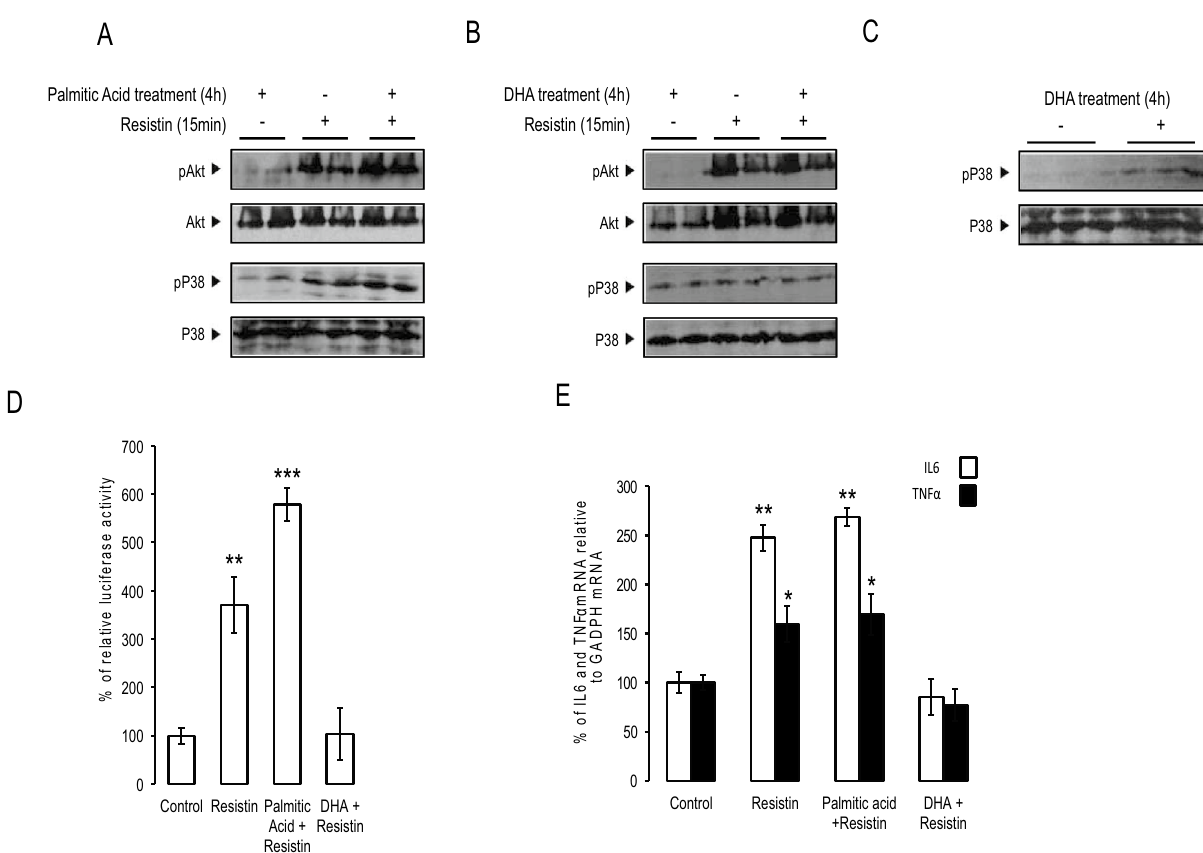
Figure 4. Palmitic acid promoted resistin action. Human SH-Y5Y cells were pretreated with palmitic acid (panel A ) or DHA (panel B ) and then stimulated by resistin. Phosphorylated Akt and p38 MAP kinase was determined by Western blot using adequate antibodies. (Panel C ) cells were treated with DHA or placebo and p38 MAP kinase phosphorylation was determined by Western blot using adequate antibodies. The presented blots in (panel A ), (panel B ) and (panel C ) are from the same membranes that were successively blotted with different antibodies. (Panel D ) human SH-SY5Y neuroblastoma cells stably transfected with NF-κB luciferase reporter gene were treated resistin, resistin + palmitic acid or resistin + DHA, and relative luciferase activity determined. Data were presented as means ± SEM (n = 3), ** and *** denoted significant differences vs control at p < 0.005 and p < 0.001, respectively. (Panel E ) Human SH-SY5Y neuroblastoma cells were treated with resistin, resistin + palmitic acid or resistin + DHA, and then IL6 and TNFα expression was determined using adequate primers, and normalized using GAPDH. Data were presented as means ± SEM (n = 3), * and ** denoted significant differences vs control at p < 0.05 and p < 0.005,